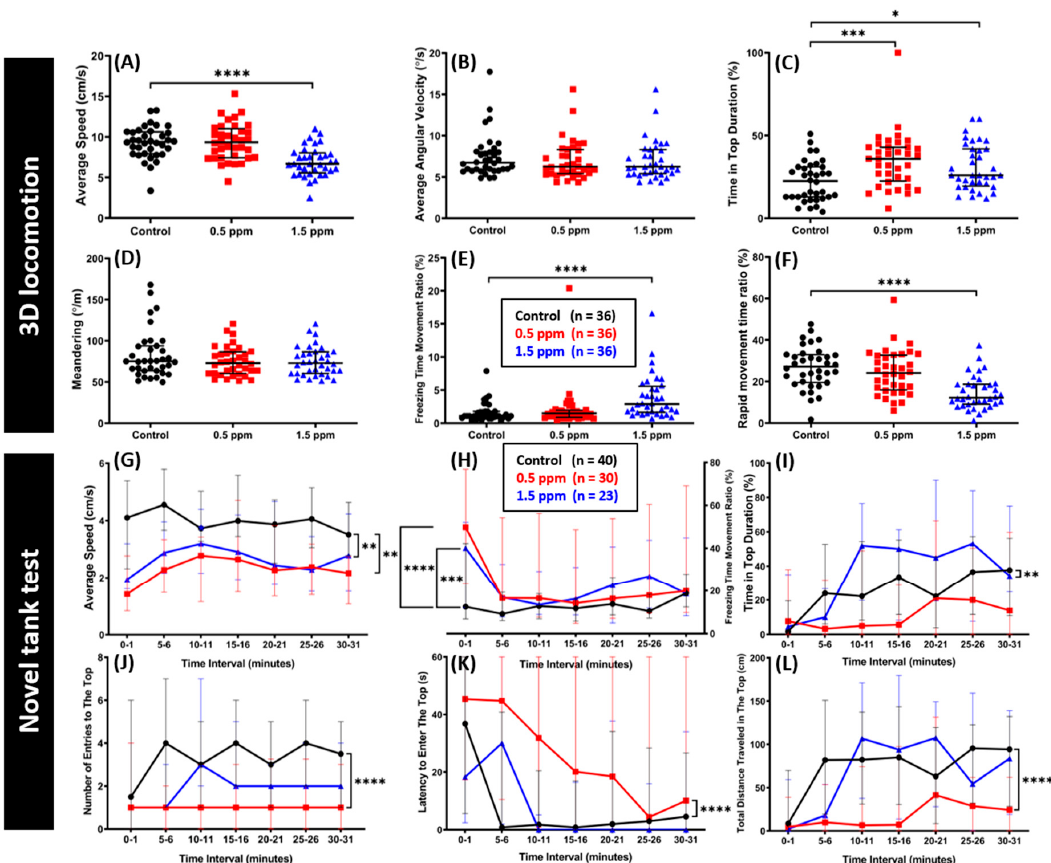
Figure 2. Comparison of behavior endpoints between the untreated control and C 70 NP-exposed zebrafish in 3D locomotion and novel tank tests after 14-day exposure. ( A ) Average speed, ( B ) average angular velocity, ( C ) time in top duration, ( D ) meandering, ( E ) freezing time movement ratio, and ( F ) rapid movement time ratio were analyzed for the 3D locomotion test. For the novel tank test, ( G ) average speed, ( H ) freezing time movement ratio, ( I ) time in top duration, ( J ) number of entries to the top, ( K ) latency to enter the top, and ( L ) total distance traveled in the top were analyzed. The data are expressed as the median with interquartile range. The 3D locomotion test data were analyzed by the Kruskal–Wallis test, with Dunn’s multiple comparisons test as a follow-up test ( n = 36 for both control and treatment groups). The novel tank test data were analyzed by two-way ANOVA with Geisser–Greenhouse correction ( n = 40 for the untreated control; n = 30 for the 0.5 ppm C 70 NP-exposed fish; n = 23 for the 1.5 ppm C 70 NPs-exposed fish; * p < 0.05, ** p < 0.01, *** p < 0.001, **** p <